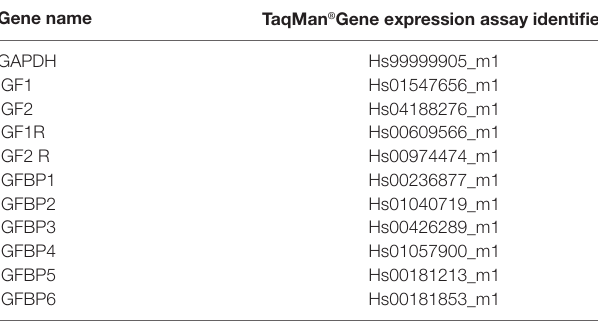
Table 1 | Assay identifiers for TaqMan